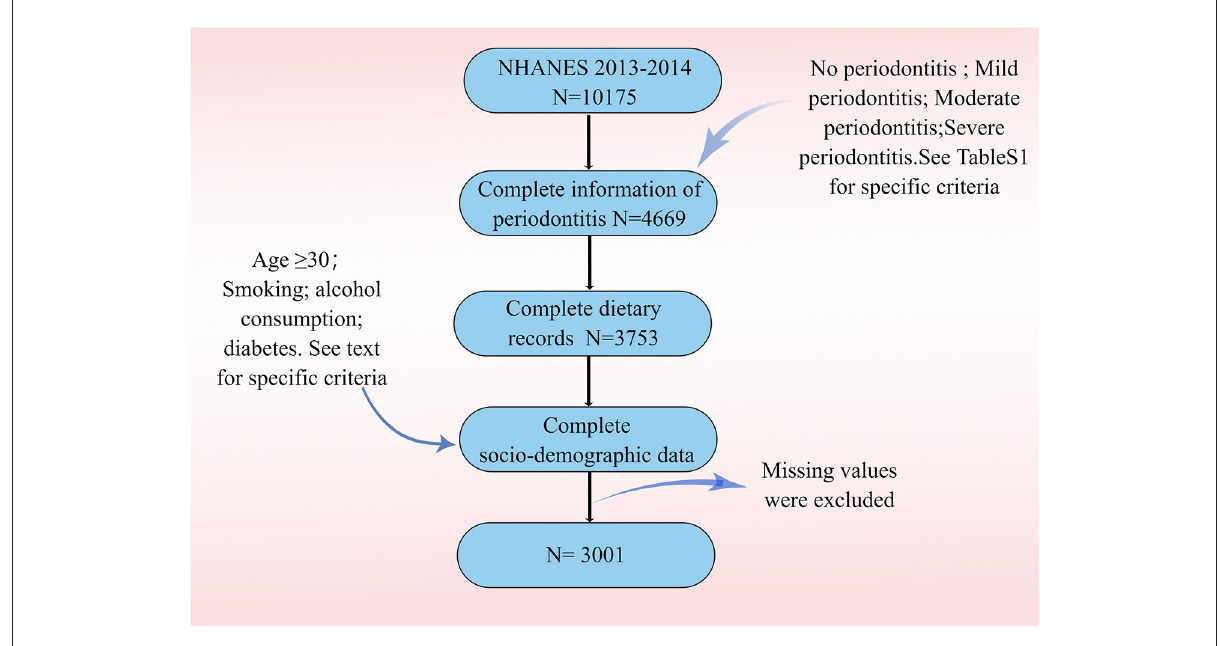
FIGURE1 Flowchart of the study population.